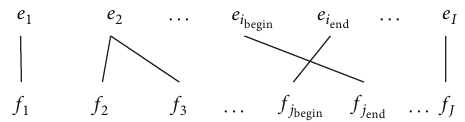
Figure 3: Alignments with a cross link of neighboring words.